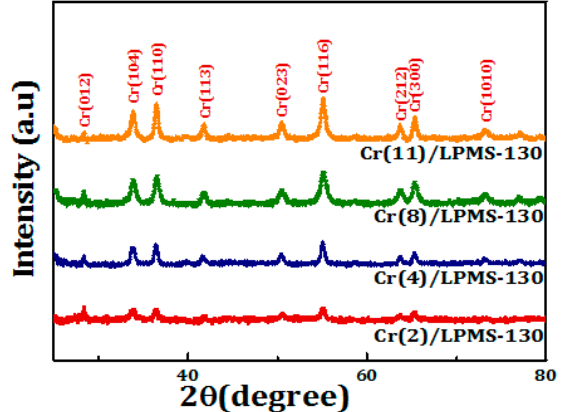
Figure 3. XRD patterns of Cr(y)/LPMS-130 prepared with varying chromium loadings. The internal structure and morphology of LPMS-130 and synthesized Cr(y)/LPMS-130 catalysts with 4 and 8 wt % Cr were investigated by TEM, and the obtained images are presented in Figure 4. The TEM images of the LPMS-130 sample shown in Figure 4A(a),B(a’) reveal the formation of large-pore mesoporous silica nanoparticles that lack long-term ordering. On the other hand, upon loading Cr with 4 wt % (Figure 4A(b),B(b’)), the TEM images of Cr(4)/LPMS-130